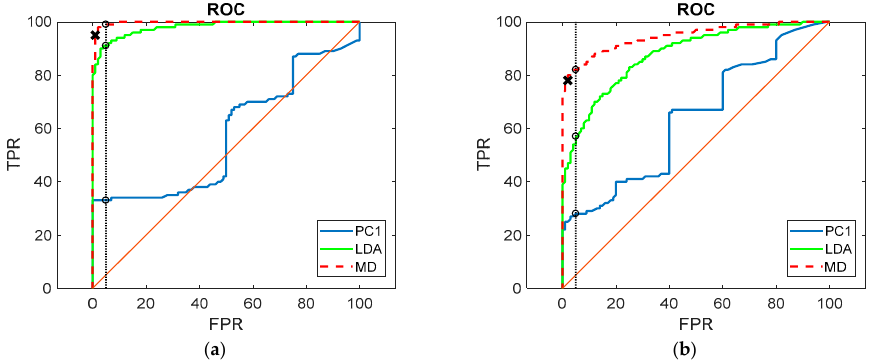
Figure 16. ( a ) ROC curves for the three classifications considering constant speed (180 Hz) but variable load (0, 1000, 1400, 1800 N)—conditions 5 to 8. ( b ) ROC curves for the three classifications considering constant load (1400 N) but variable speed (90, 180, 280, 370, 470 Hz)—conditions 2, 6, 10, 14, 17.The 5% significance threshold values are highlighted with the black circles; the black x denotes the position of the NI threshold computed according to the MC repetition introduced in Section 2.4.1.